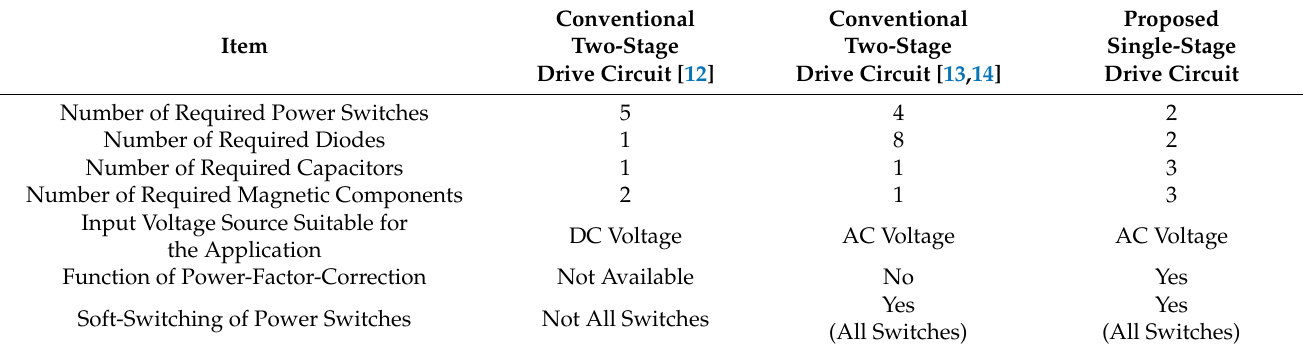
Table 1. Comparisons between the conventional drive circuits and the proposed version for a piezoelectric ceramic